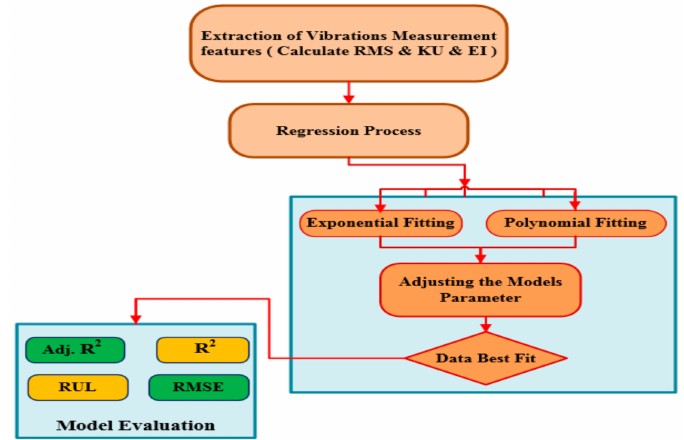
Figure 3. Schematic of regression